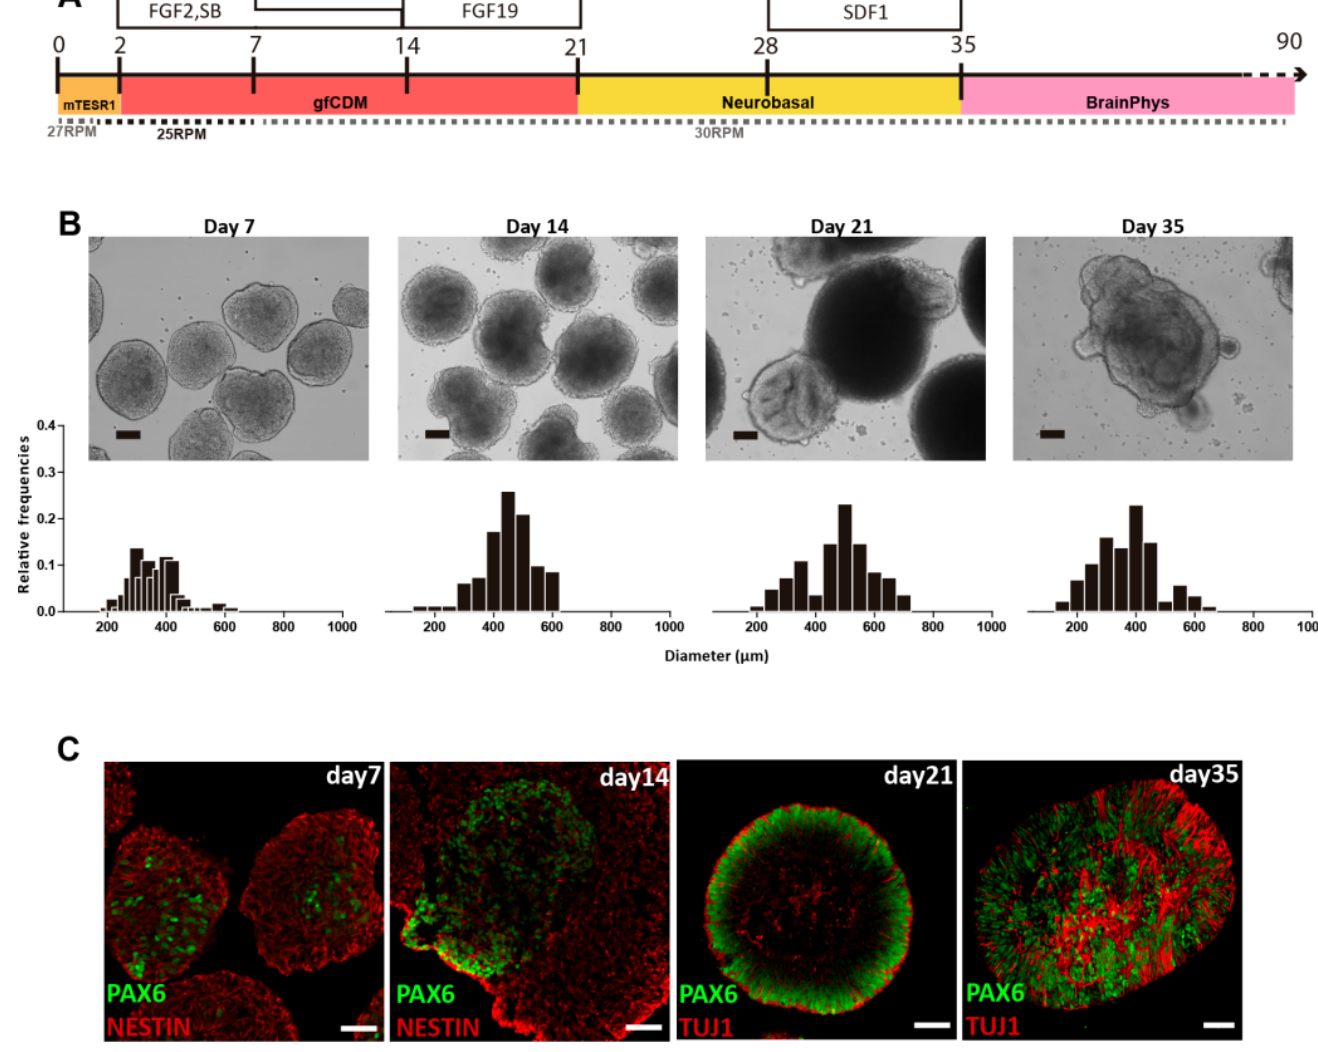
Figure 5. Generation of human iPSC-derived cerebellar organoids using 0.1 L VW bioreactors. ( A ) Process for differentiation of iPSCs to cerebellar organoids. ( B ) Brightfield photomicrographs of spherical iPSC-derived organoids during cerebellar differentiation process. Scale bar: 100 µ m. Graphs of organoid diameter distributions indicate homogeneous sizes were maintained. ( C ) Im- munofluorescence for NESTIN, PAX6, and TUJ1 during cerebellar differentiation indicate efficient neural induction in iPSC-derived organoids. Scale bar: 50 µ m. Adapted from Silva et al. (2020)